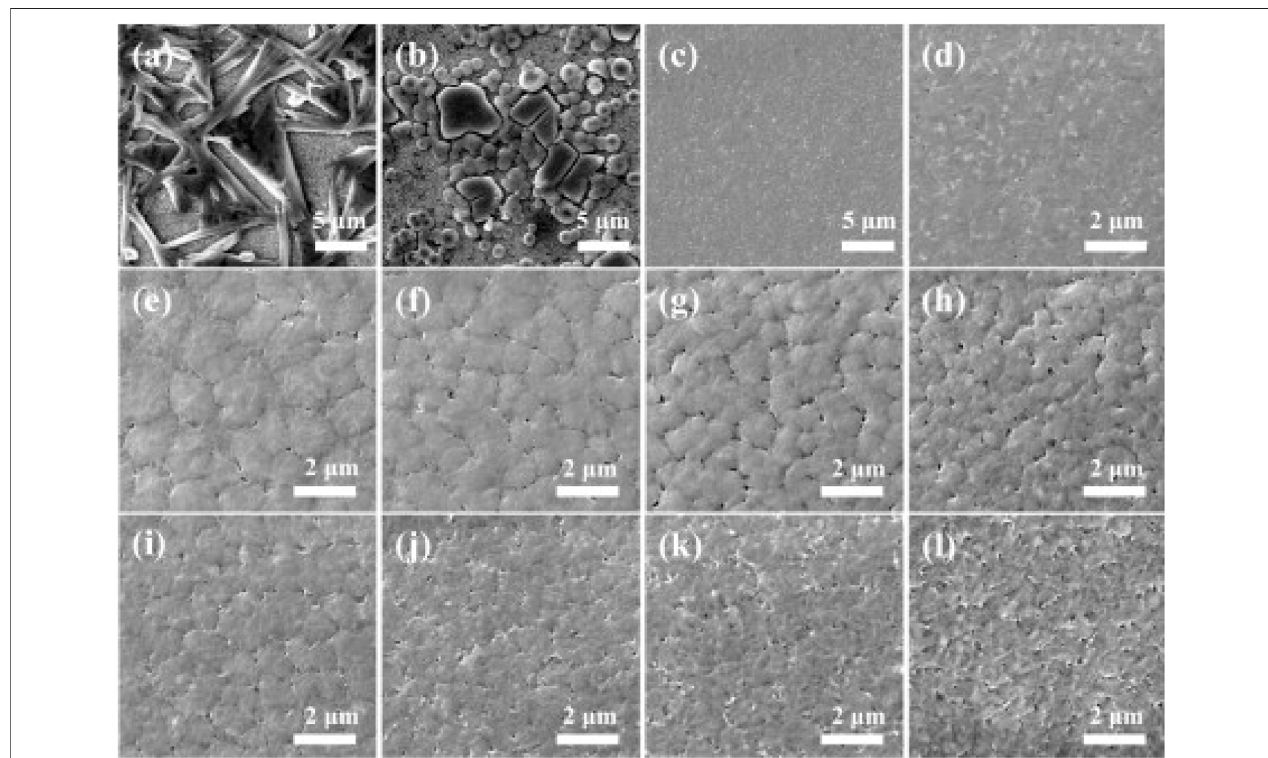
FIGURE7| SEM images ofMAPbI3 fi lms spin-coated using different solvents. (A) Pure DMF, (B) Pure GBL, (C) and (D) Pure DMSO, (E – H) DMF – DMSO mixtures containingDMFvolume fractions of20%,40%,60%,and80%,respectively, (I – L) GBL-DMSO mixturescontainingGBLvolumefractionsof20%,40%,60%,and 80%, respectively. Reproduced with permission (Cai et al., 2015). Copyright 2015,